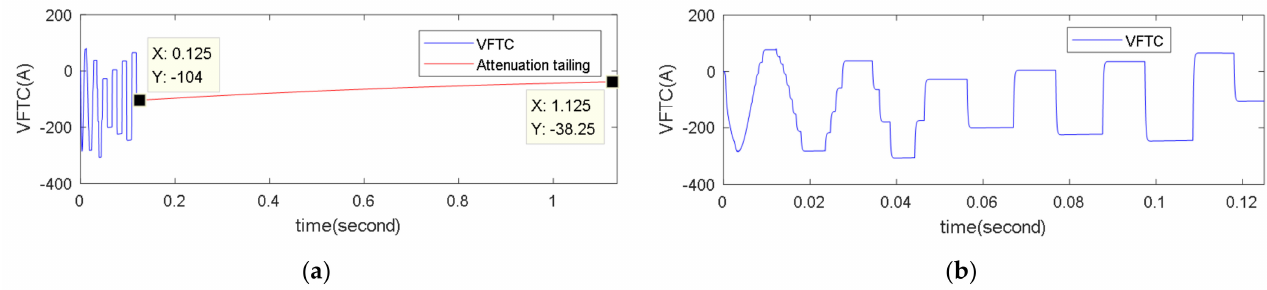
Figure 14. VFTC waveforms in the whole process at the output of filter (AD sampling) (S. No4). ( a ) VFTC waveforms; ( b ) the expansion of VFTC